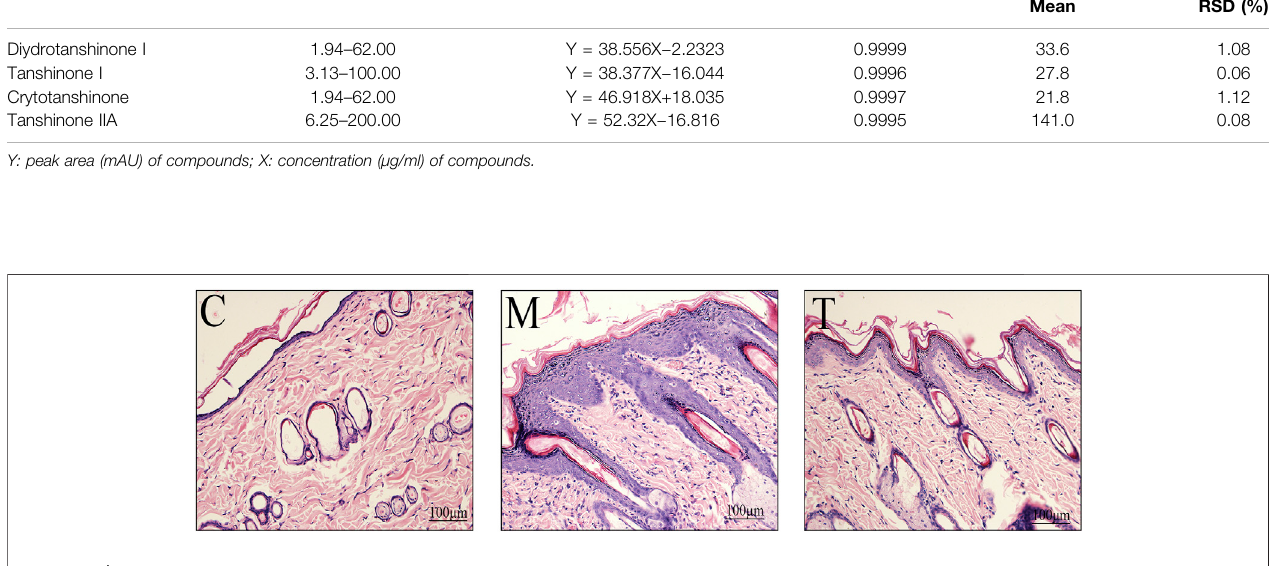
Frontiers in Pharmacology |